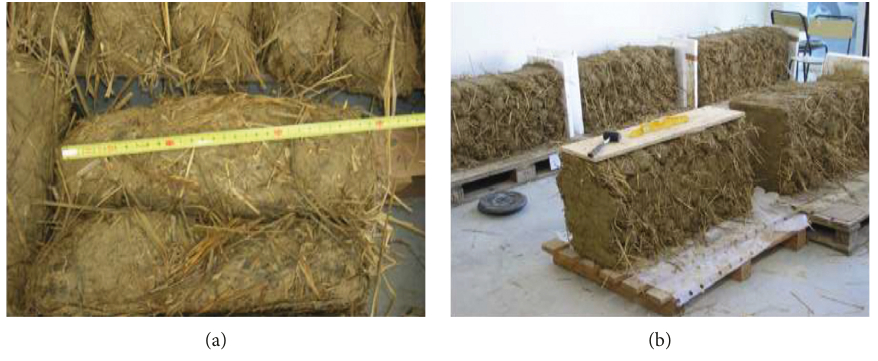
Figure 3: Single cob element (a) and cob walls (b).